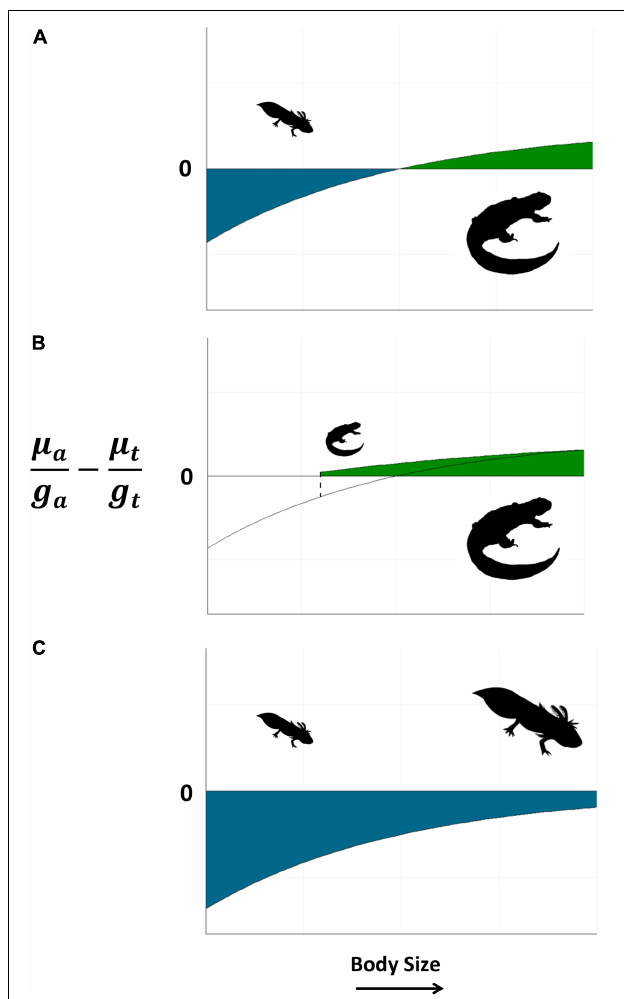
FIGURE 3 | Differences in the expected risk vs growth potential between aquatic (a) and terrestrial (t) habitats change as a function of body size, and can be used to understand the evolution of different amphibian life histories and transitions between habitats. Adapting the approach taking by Werner et al. (1983) we have plotted a horizontal line where the trade-off between = µ t mortality ( µ ) and growth (g) in each habitat is equivalent, µ a g g t . Below this a line, we expect the aquatic environment to be more favorable and vice versa for the terrestrial environment. (A) Illustrates a version of the classic amphibian life cycle, where this framework can predict the optimal size at metamorphosis. In (B) the aquatic stage is lost in favor of direct development and parental care, which increases the safety of the terrestrial stage above the scenario depicted in (A) . In (C) we illustrate a paedomorphic species in which the terrestrial stage is lost and species retain gills and remain in aquatic habitats throughout their